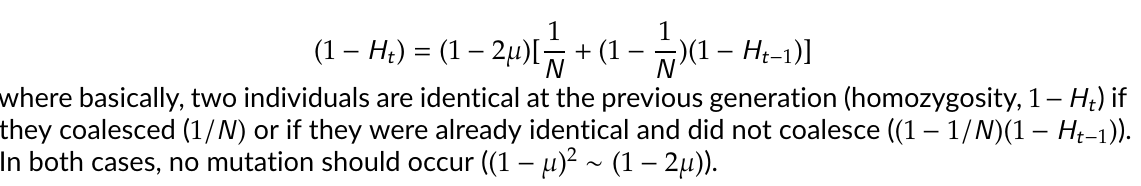
Figure S7 – Same Figure as supplementary figure S6, but with shaded areas representing standard deviation instead of standard error of the